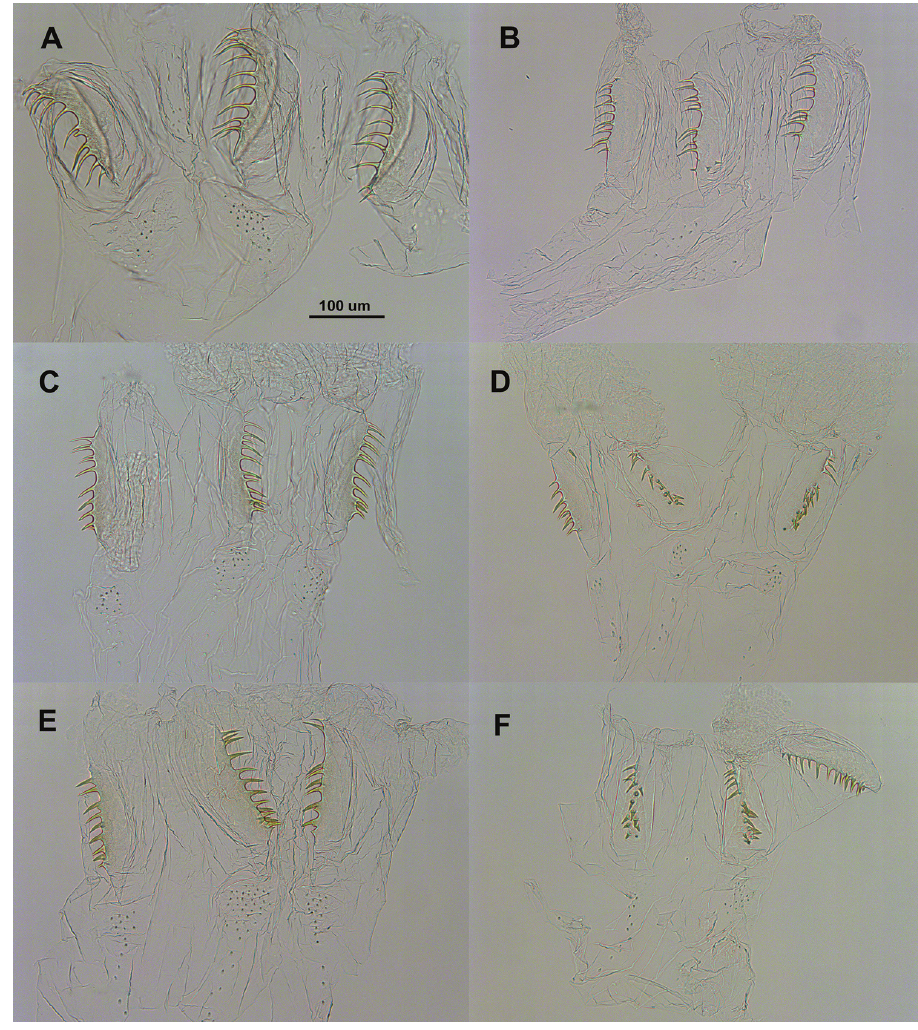
Figure 2. Enteric valve armatures. Parvitermes mexicanus comb. n., A worker B soldier. Parvitermes mesoamericanus sp. n. C worker D soldier. Parvitermes yucatanus sp. n. E worker F soldier. Posterior (end attached to P3) at top of each